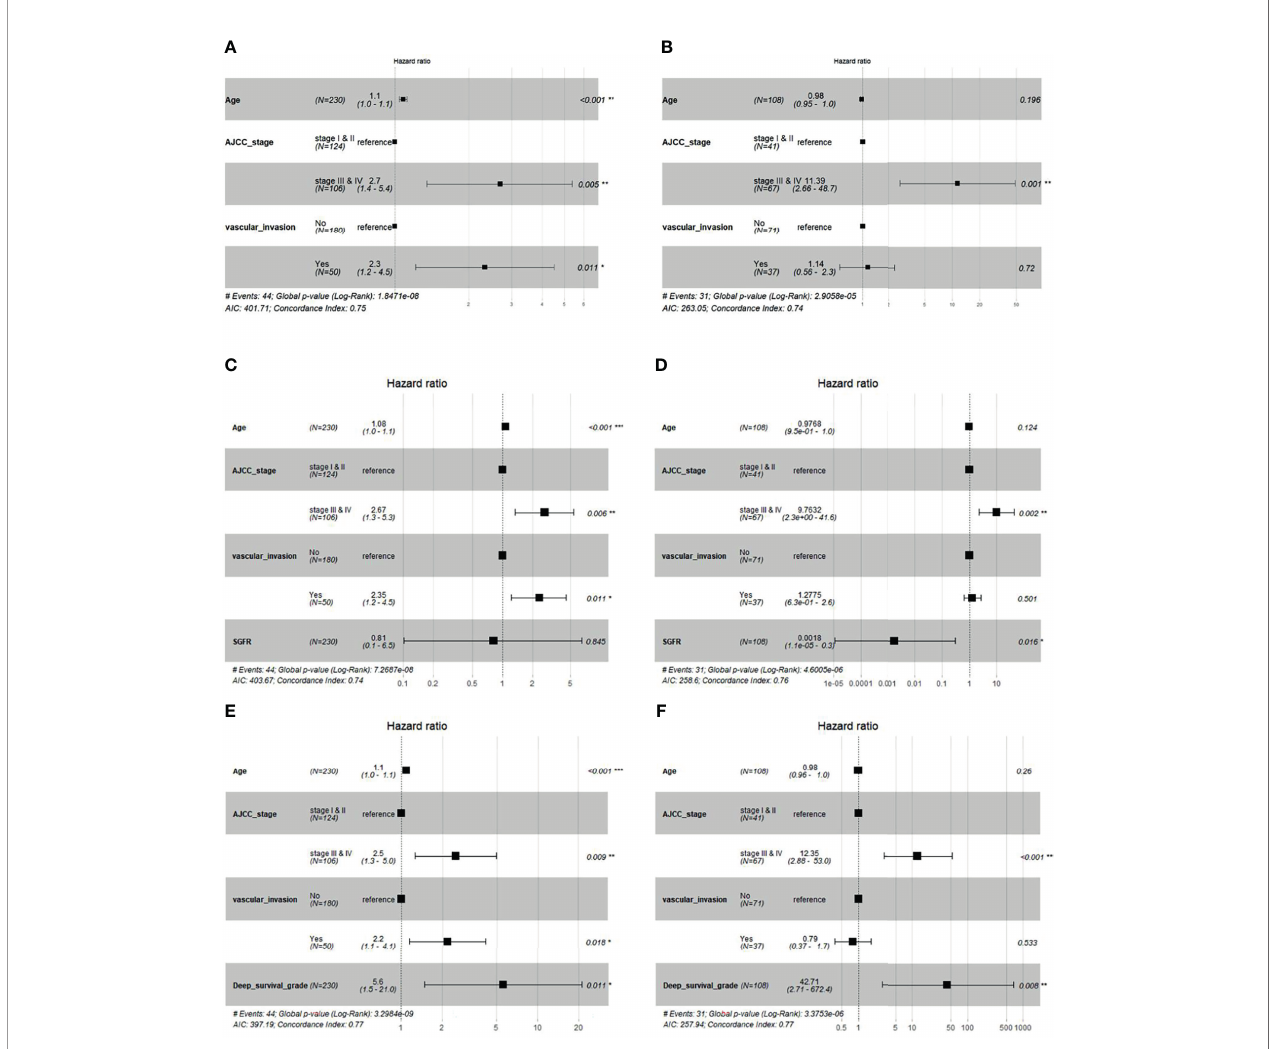
FIGURE 6 | Cox regression forest plot of baseline model, baseline + Semi-quantitative gland formation ratio (SGFR) model and baseline + deep survival grade model. (A, B) are the baseline multivariable Cox models of age, AJCC and vascular invasion for validation set and test set, respectively. (C, D) are multivariable Cox models of age, AJCC, vascular invasion and SGFR for validation set and test set, respectively. (E, F) are multivariable Cox models of age, AJCC, vascular invasion and deep survival grade for validation set and test set,